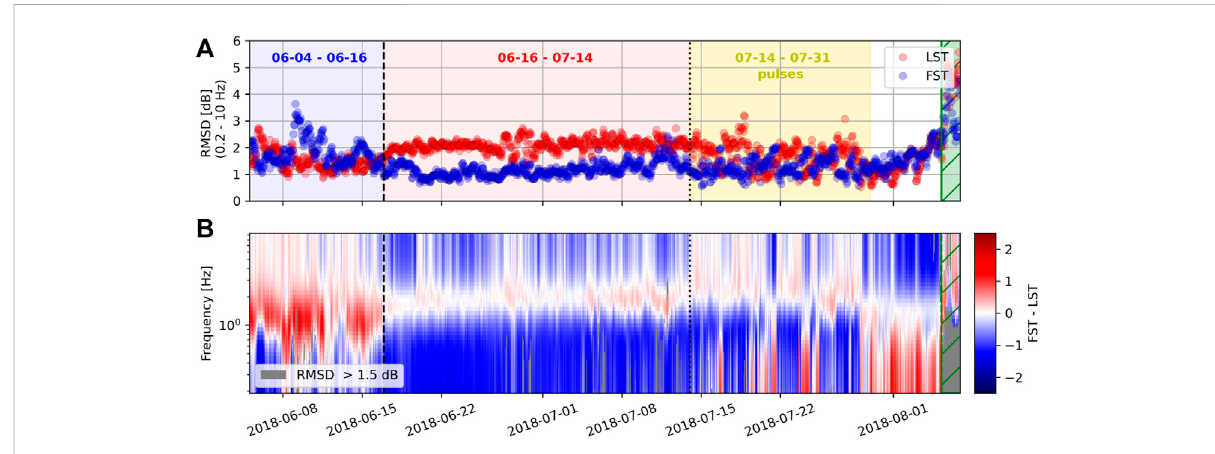
FIGURE 7 Jet noise similarity spectra fi tting results. (A) Shows the mis fi t (RMSD) when fi tting the LST (red) and FST (blue) similarity spectra to the power spectrashowninFigure5B.WiththeRMSDbeinggenerallybelowthreethesimilarityspectra fi ttheeruptiondatawell. (B) Showsthemis fi tdifference spectrogram with red marking times and frequencies where the LST similarity spectrum fi ts the data better and in blue when the FST similarity spectrum fi ts the data better. The background colors and vertical dashed and dotted lines are the same as in Figure